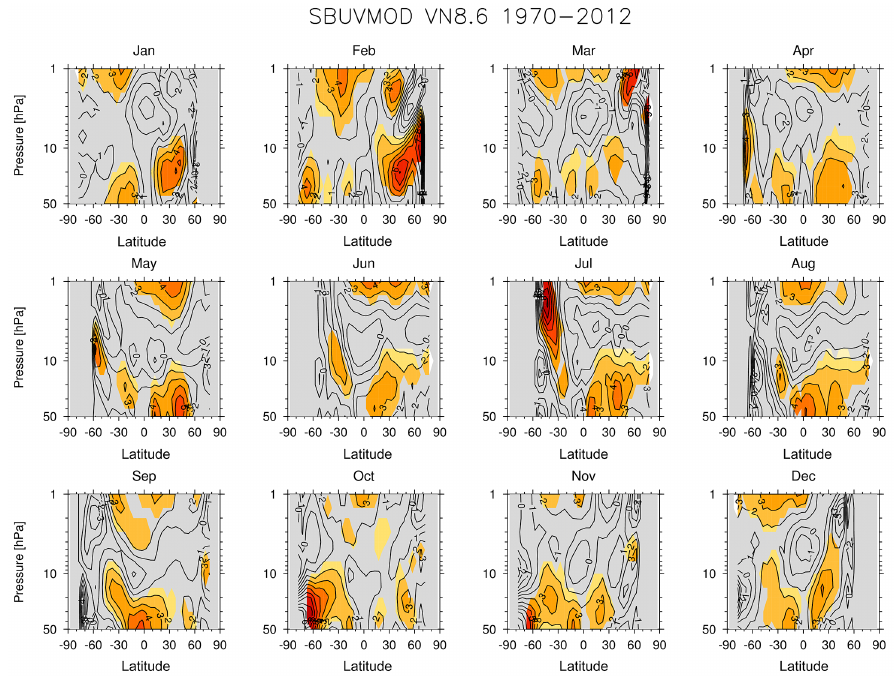
Figure 13. The percent (%) monthly solar-ozone response (SOR) (per 130SFU) in the SBUVMOD VN8.6 dataset for the period 1970–2012. The contour interval is 1%. The grey shading denotes regions where the SOR is not statistically distinguishable from 0 at the 95% confidence